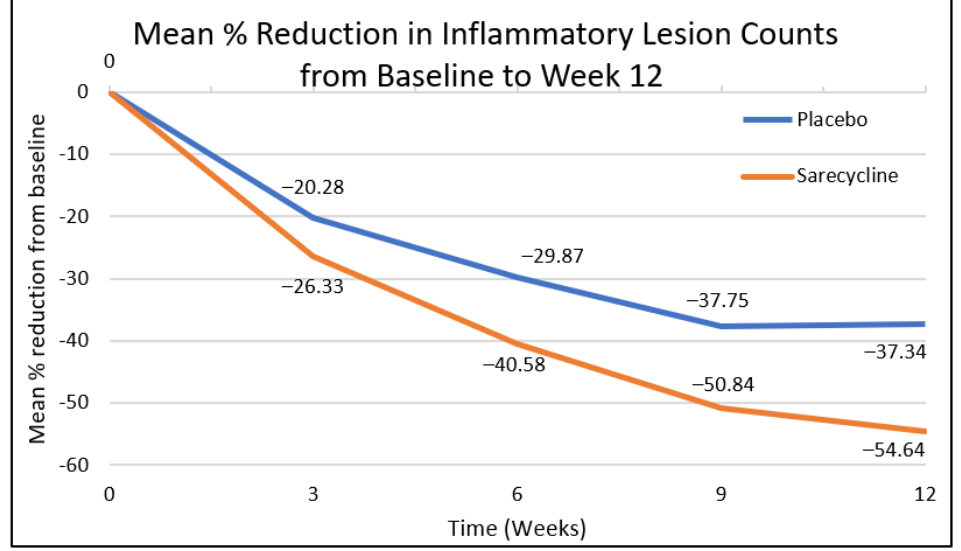
Figure 1. Mean % reduction of facial inflammatory lesion count from baseline to week 12. Non-inflammatory (comedonal) facial lesions in Hispanics decreased by 19% vs. 16% at week 3 (confidence interval (CI): − 3.60 ( − 9.14, 1.95), p = 0.2031), 31% vs. 25% at week 6 (CI: − 6.20 ( − 13.24, 0.84), p = 0.0842), and a statistically significant reduction by 41% vs. 28% at week 9 (CI: − 6.20 ( − 13.24, 0.84), p = 0.0006) and by 41% vs. 28% at week 12 (CI: − 12.91 ( − 20.69, − 5.13), p = 0.0012) in patients on sarecycline vs. placebo,